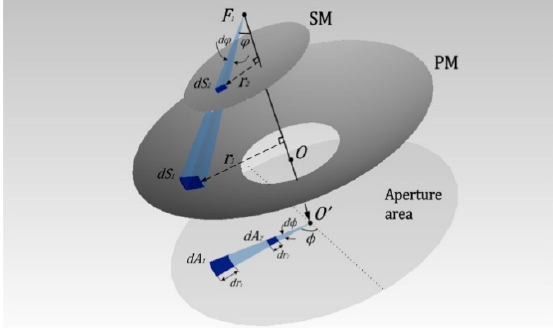
Figure 5. 3D sketch of optical projection of TSD combination.